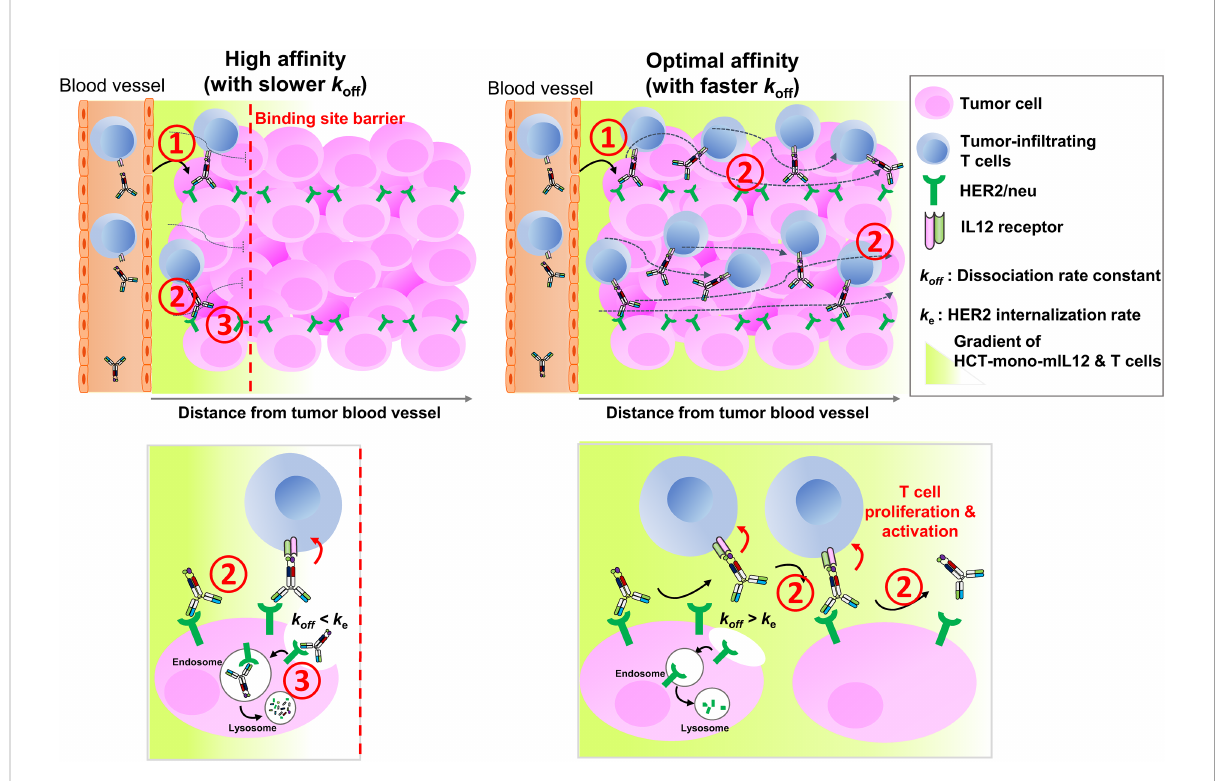
FIGURE 6 Schematics of in vivo intratumoral penetration of HCT-mono-mIL12 as a function of anti-HER2 binding kinetics, and its effect on tumor in fi ltration and activation of CD4 + and CD8 + T cells in the TME. The tumor localization and intratumoral penetration of HCT-mono-mIL12 are governed by three major steps: (1) vascular transport (extravasation) and tumor retention, (2) interstitial transport, and (3) HER2 receptor- mediated clearance. For tumor retention after extravasation (step 1), HCT-mono-mIL12 requires an anti-HER2 af fi nity above a threshold to strongly bind tumor cells; otherwise, it will be systemically eliminated. The interstitial transport (step 2) and HER2 receptor-mediated clearance (step 3) are mainly governed by the dissociation rate constant ( k off ) for HER2 antigen. In step 2, the slower the k off , the longer it takes to diffuse over a certain distance ( left panel ) and the faster the k off , the farther it transports across the tumor interstitium ( right panel ). In step 3, a slower k off than the HER2 internalization rate ( k e ) leads to rapid depletion of HCT-mono-mIL12 ( left panel ) and a k off faster than k e leads to the extracellular presence and deeper penetration of HCT-mono-mIL12 ( right panel ). A deep and wide distribution of HCT-mono-mIL12 can induce the tumor in fi ltration of CD4 + and CD8 + TILs into the distal regions from the blood vessels and/or stimulate the in situ proliferation and activation of the TILs to kill tumor cells, resulting in profound antitumor ef fi